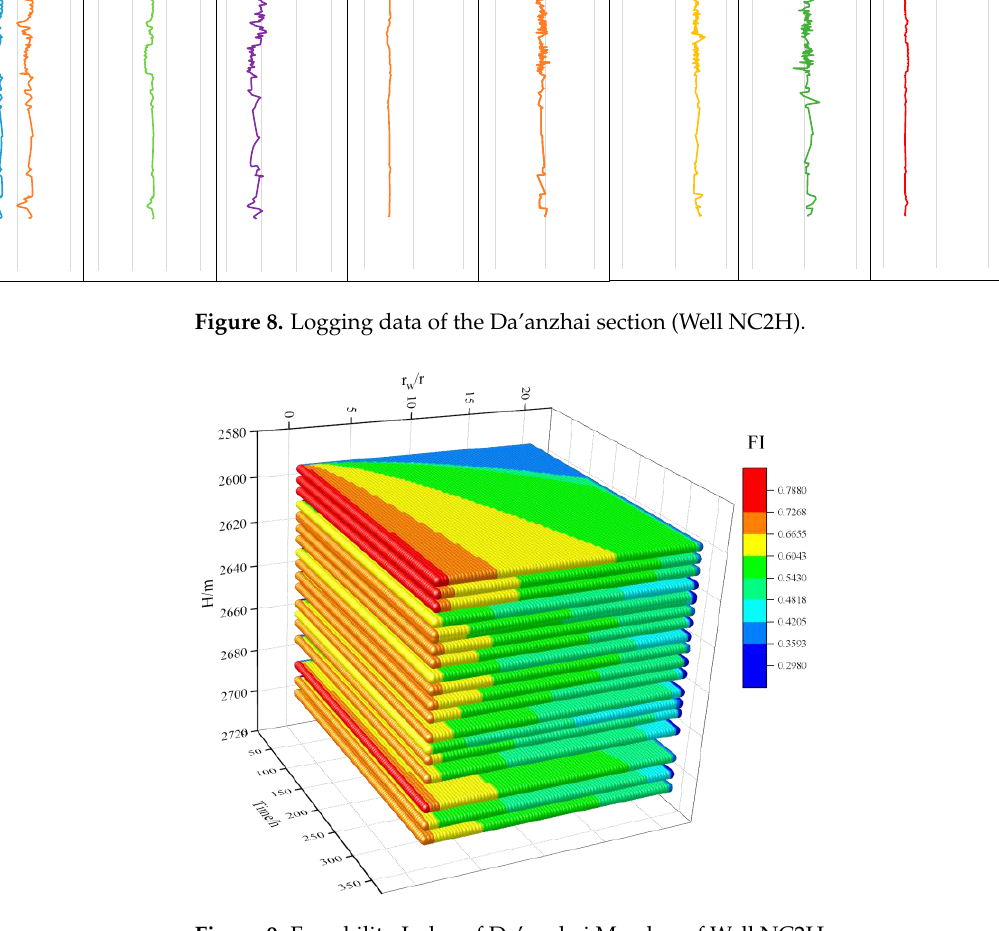
Figure 9. Fracability Index of Da’anzhai Member of Well NC2H. In Figure 9, the redder the color, the higher the FI and the greater the fracturing feasibility; the bluer the color, the lower the fracturing index and the fracturing feasibility are. Figure 9 shows that, in the Da’anzhai section of Well NC2H, the fracability index at the well wall near 2600 m is 0.78, which is the maximum value in this interval, thus indicating that it is easier to conduct fracturing operations in that region. Simultaneously, at the same depth, the FI near the wellbore is higher because the rock near the wellbore demonstrates a high degree of hydration and is more prone to fracture. The change law of FI with time and dimensionless distance is similar to the change law of water saturation rate in Figure 3. Figure 9 shows that when H = 2600 m, the rock is most likely to fracture. Therefore, according to Formulas (9) and (10), the variations in rock fracture pressure with time and dimensionless distance at a depth of 2600 m were calculated. The results are shown in Figure